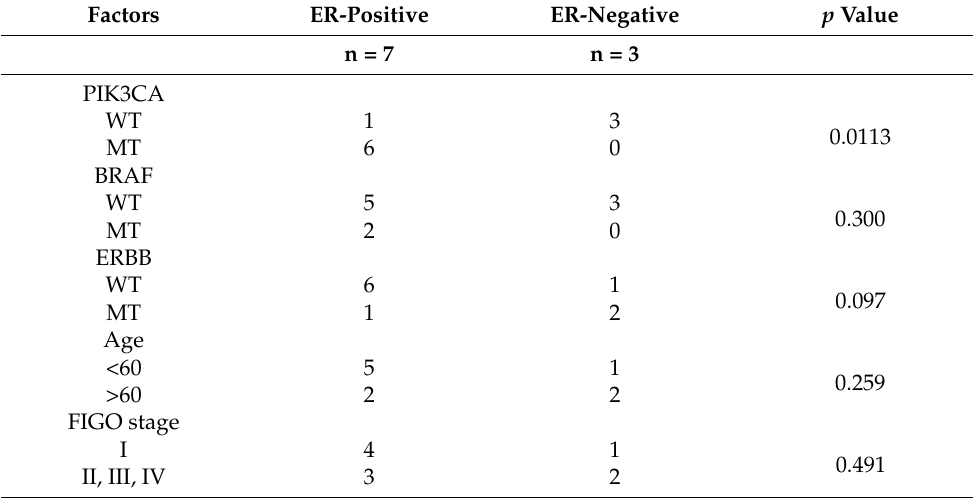
Table 2. Association between ER expression and mutation status in patients with